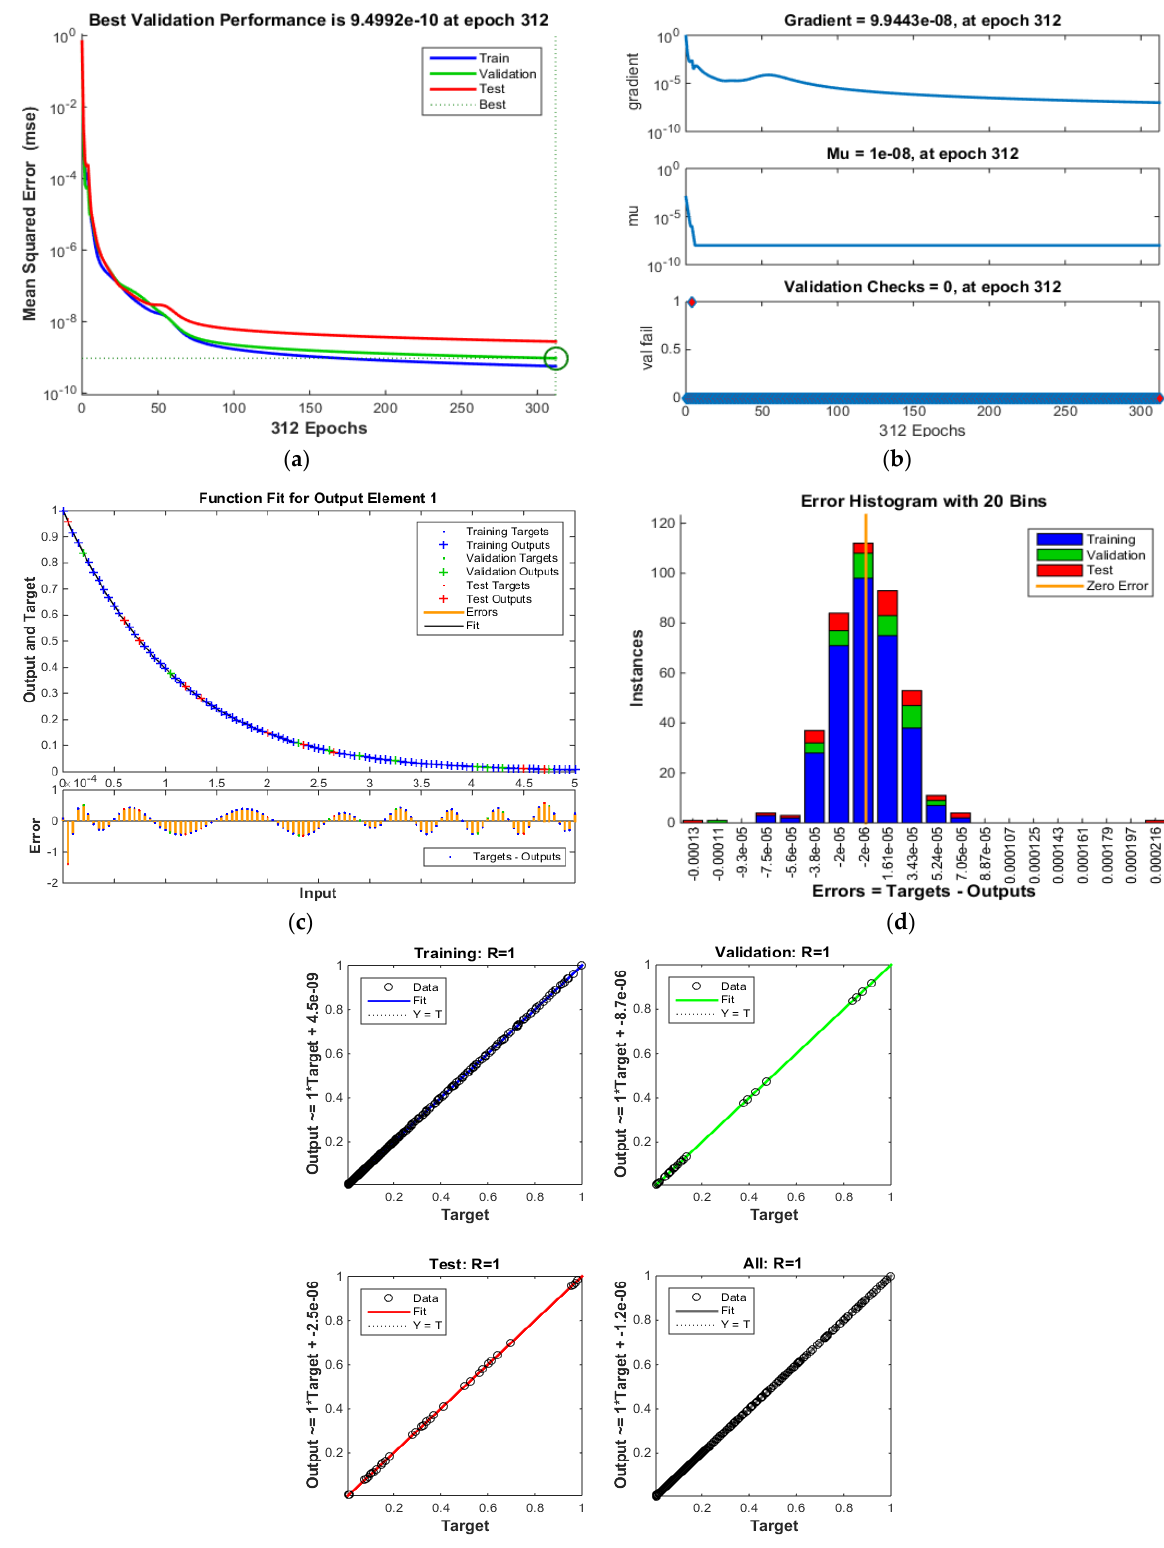
Figure 9. Graphic representation for designed LMT-ABPNN for solving cases of 𝑀𝑎 for 𝜃(𝜂) of MHD-SGFM. ( a ) MSE Result, ( b ) Results of the transition state, ( c ) Fitness of the curve, ( d ) Histogram for error analysis, ( e ) Regression.